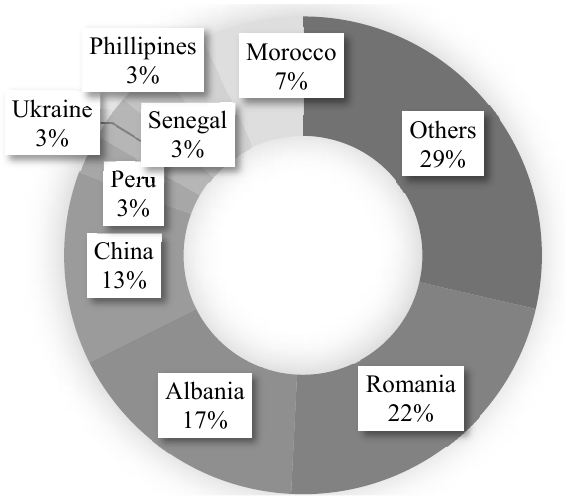
Figure 5. Origin of immigrants in Tuscany (data are taken from “Progetto PAeSI, Pubblica Amministrazione e Stranieri Immigrati”).